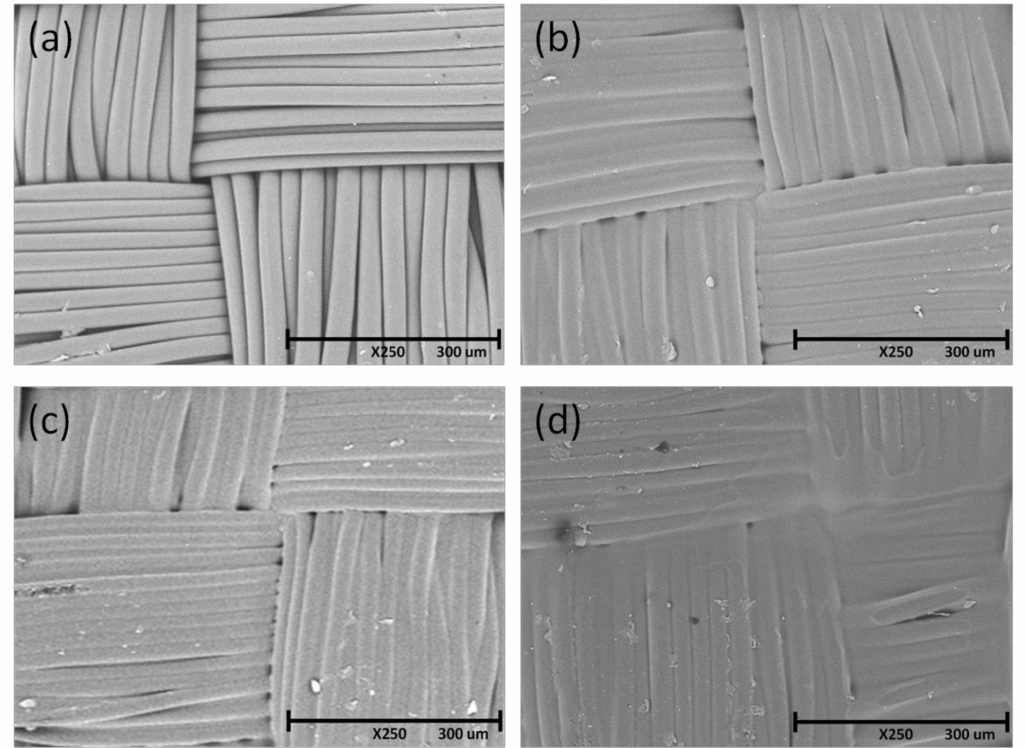
Figure 10. SEM micrographs of the sample surfaces for neat PP ( a ), and PP/PU-PFPE dried at ambient conditions ( b ), dried at 70 ◦ C ( c ), or at 70 ◦ C and 5 × 10 6 Pa ( d